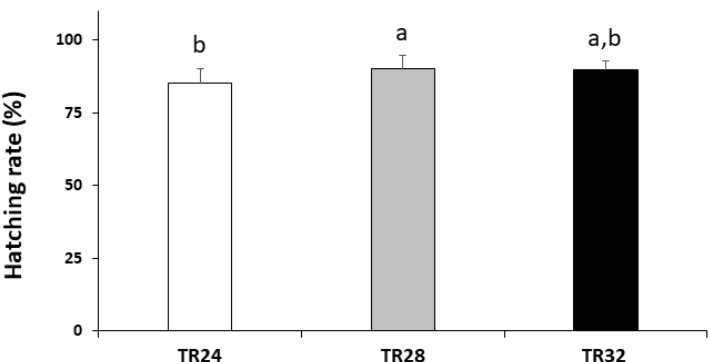
Figure 2. Hatching rate (mean ± standard deviation) of Atractosteus tropicus larvae when embryos were incubated at different thermal regimens. Lowercase letters at the top of each bar indicate statistical differences among experimental groups (ANOVA, p < 0.05; N = 10).